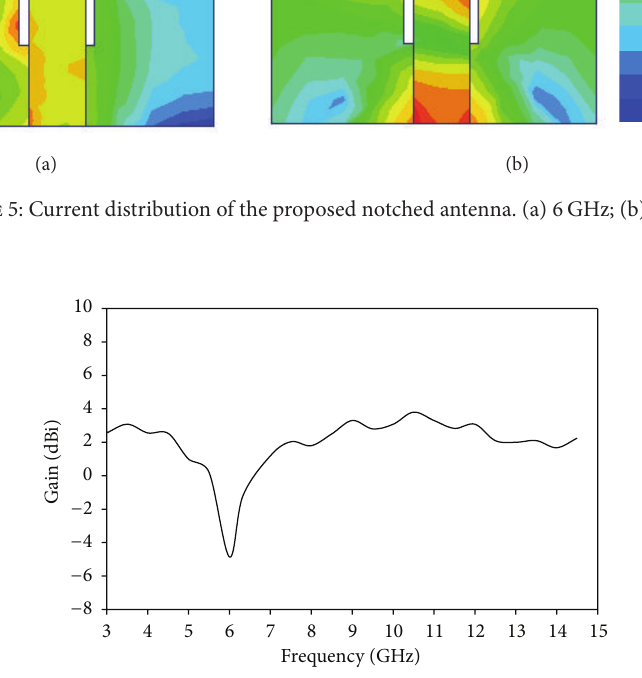
Figure 6: Measured gain of the proposed notched